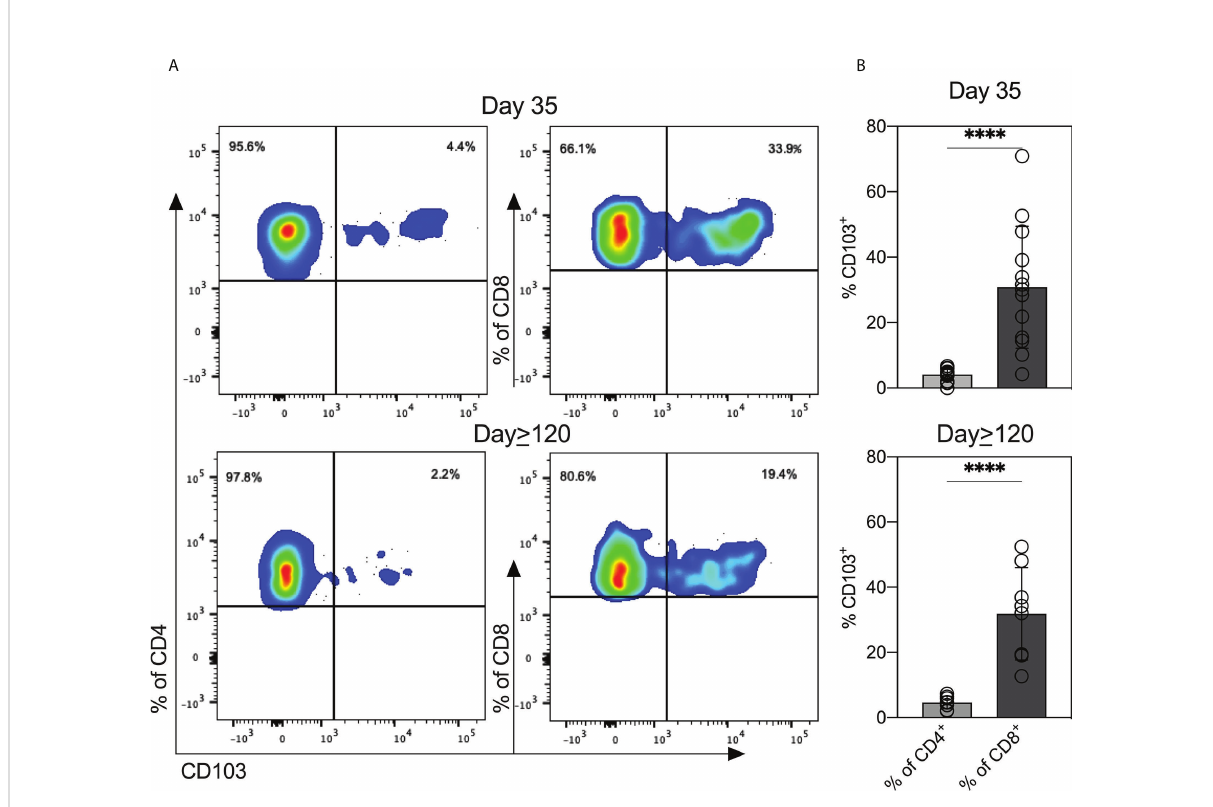
FIGURE 5 T cells in breastmilk from SARS-CoV-2-infected women display high levels of mucosal-homing marker. (A) Scatter plots from one representative participant showing CD103 expression on CD4 + and CD8 + T cell populations in milk obtained at the two indicated timepoints. (B) Expression of CD103 on CD4 + and CD8 + in breastmilk cells ( n = 13 Day 35; n = 8 Day ≥ 120). Independent t -tests were performed to analyze differences between CD103 expression within CD4 + and CD8 + T cells.